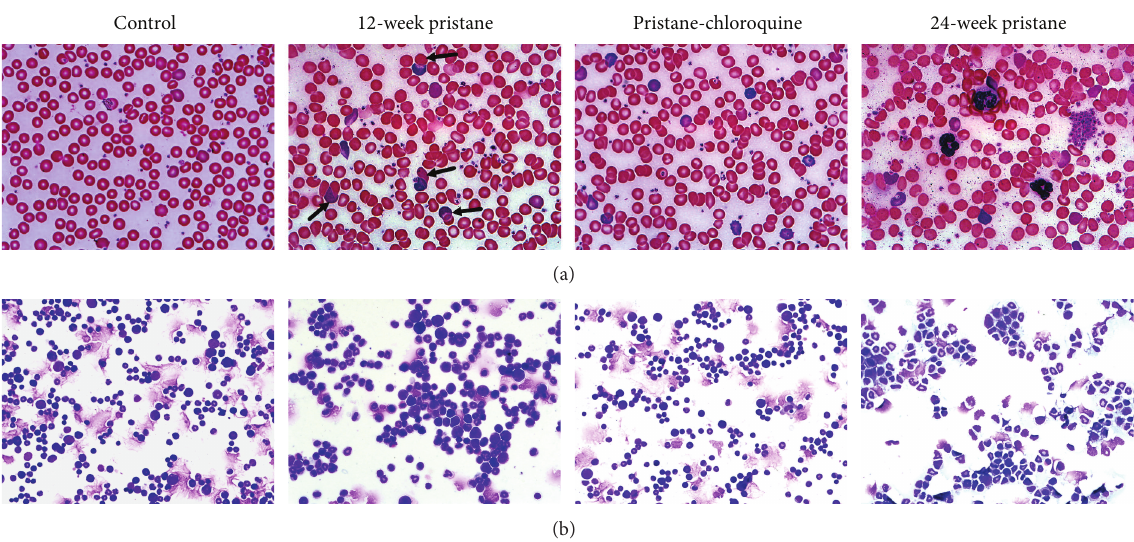
Figure 2: Effects of pristane alone or combined with chloroquine on cytological characteristics in blood and bone marrow. Wright-Giemsa staining was performed in peripheral blood (a) and bone marrow (b) smears. Hemophagocytosis (arrows), poikilocytosis, polychromasia, hypochromia, and anisocytosis of erythrocytes were observed in blood smear of pristane-treated mice. Bone marrow cytology depicted hypocellularity in erythroid progenitors, poikilocytosis, and nonerythroid lineage clonal expansion following treatment with pristane for 12 weeks or 24 weeks. And the severity of poikilocytosis was attenuated in the presence of